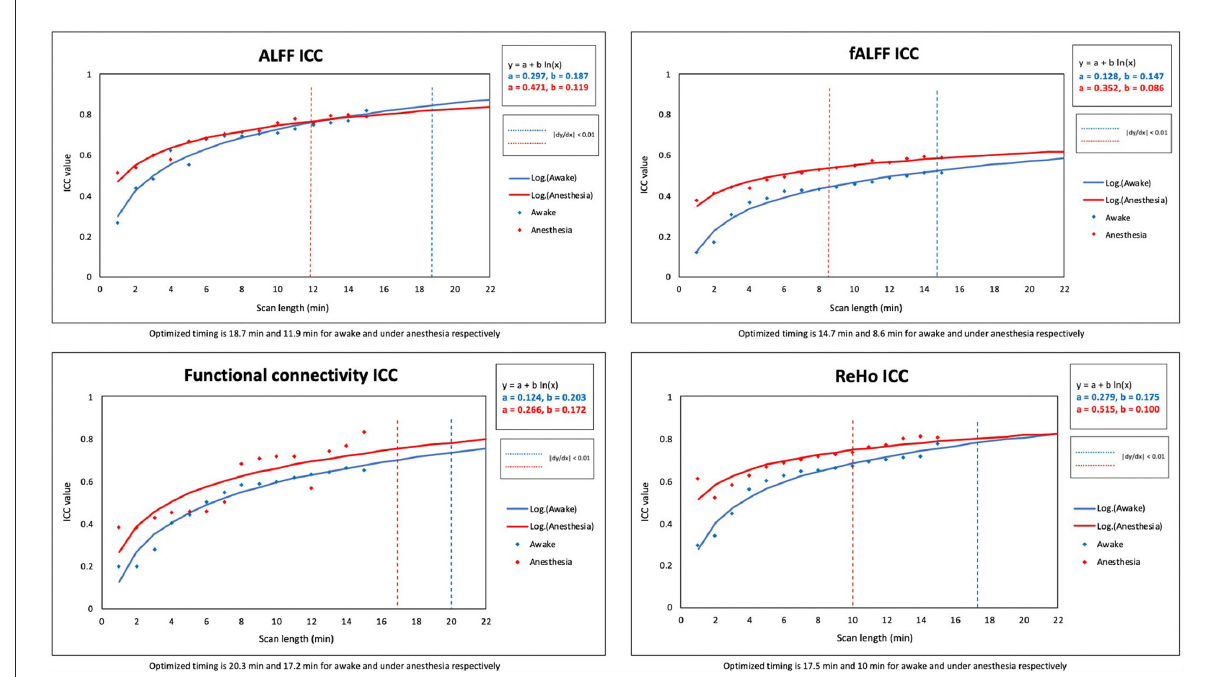
FIGURE3 ICC maps of the amplitude of low-frequency fluctuation (ALFF), fractional amplitude of low-frequency fluctuation (fALFF), functional connectivity (FC), and regional homogeneity (ReHo) in two states of awake and under anesthesia and the difference maps between awake and under anesthesia states (blue corresponds to higher ICC in awake and red corresponds to higher ICC under anesthesia).